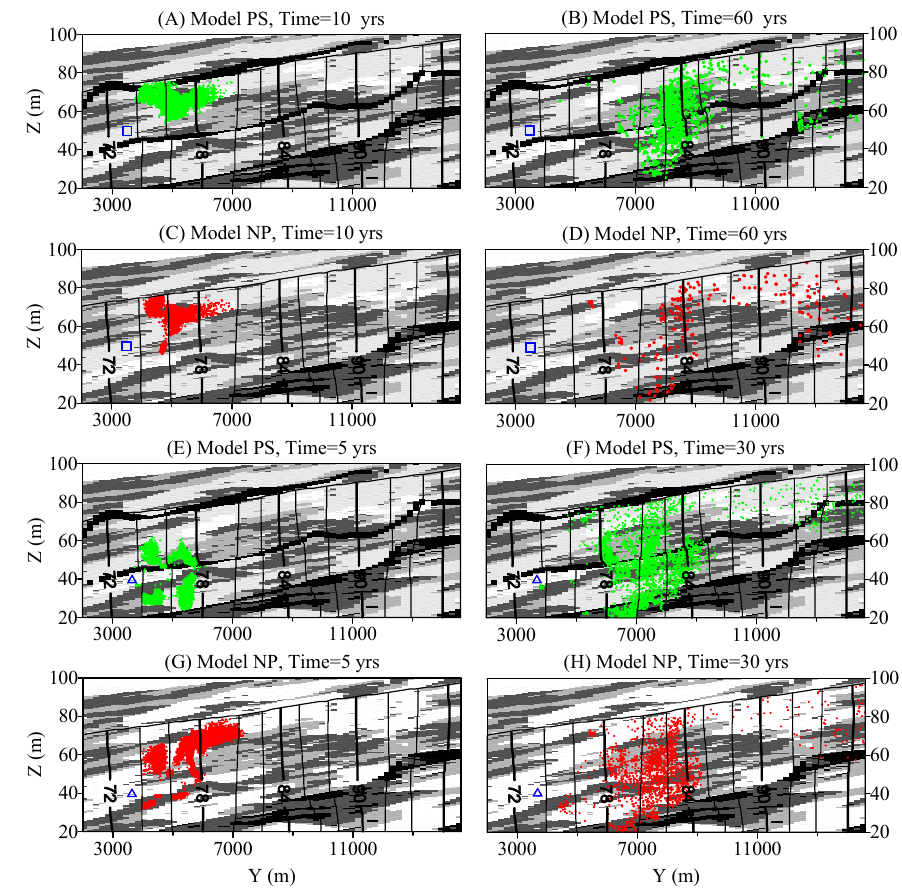
Figure 8. Effect of paleosol boundaries on backward solute transport. Particles releases from hypothetical well screens located above ( A – D ) and below ( E – H ) the second paleosol layer. A, B, E and F are model PS (with paleosol) results. C, D, G and H are model NP (without paleosols) results. The small blue rectangle in ( A – D ), and the small blue triangle in ( E – H ) represent the location of the simulated well screen.